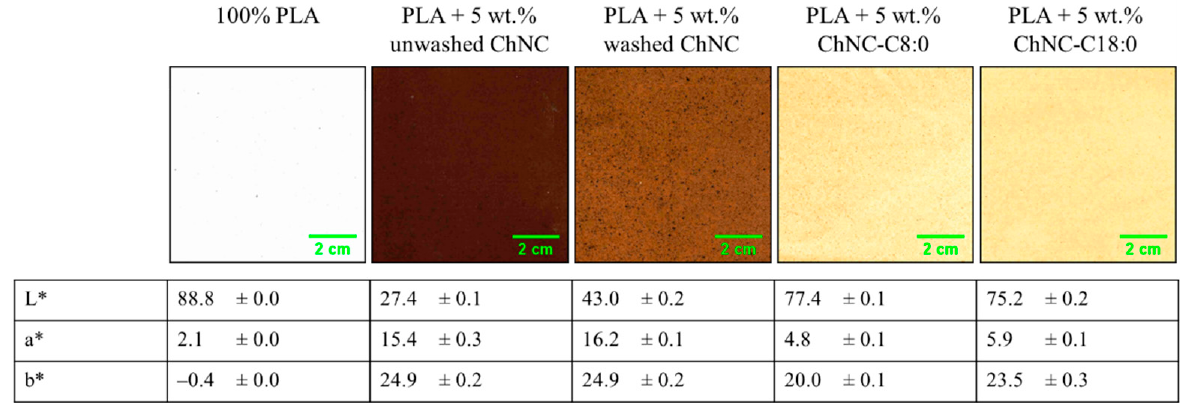
Figure 6. Pictures of nanocomposites containing 5 wt.% (modified) chitin nanocrystals and their corresponding L*, a*, and b* scores.